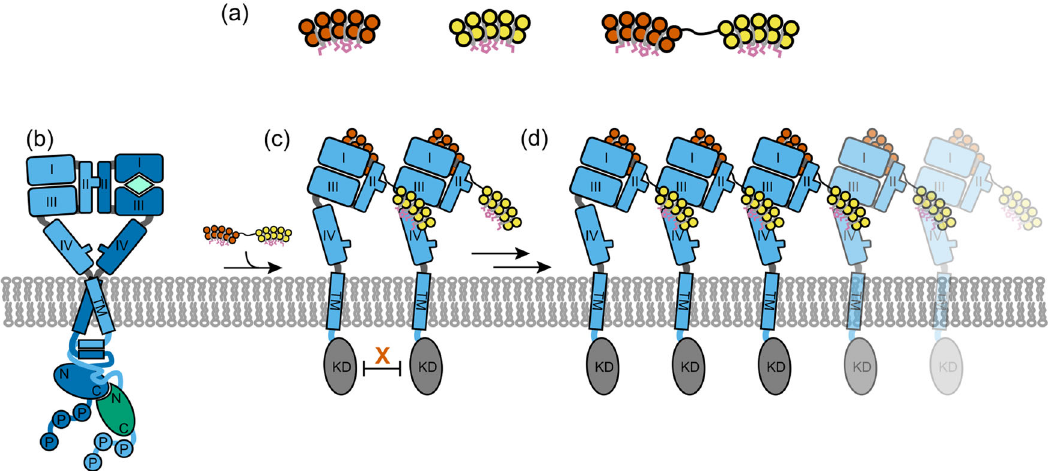
Fig. 1 Concept of bipDARPins and possible modes of binding to HER2. a Monovalent, monoparatopic DARPins (9.26 binding to extracellular subdomain I, vermillion; G3 binding to extracellular subdomain IV, yellow) and design of bipDARPin 6L1G (right), connecting 9.26 and G3 through a short linker. b Ligand-activated (e.g., by heregulin, mint) HER2:HER3 (sky blue, blue) heterodimers are able to stimulate proliferation and survival. c , d Bivalent intermolecular binding of bipDARPins may induce the formation of ( c ) inactive dimers or ( d ) oligomerization into daisy chains. In both cases, the kinase domains are separated and thus inactive. HRG heregulin, TM transmembrane helix, KD kinase